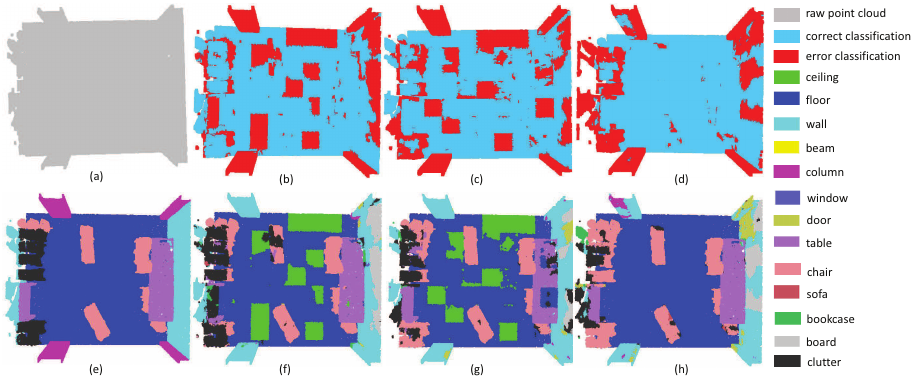
Figure 14. openspace on S3DIS. ( a ) input, ( e ) ground truth, ( b , f ) the classification result by PointNet++, ( c , g ) the classification result by PointSIFT, and ( d , h ) the classification result by SAN.